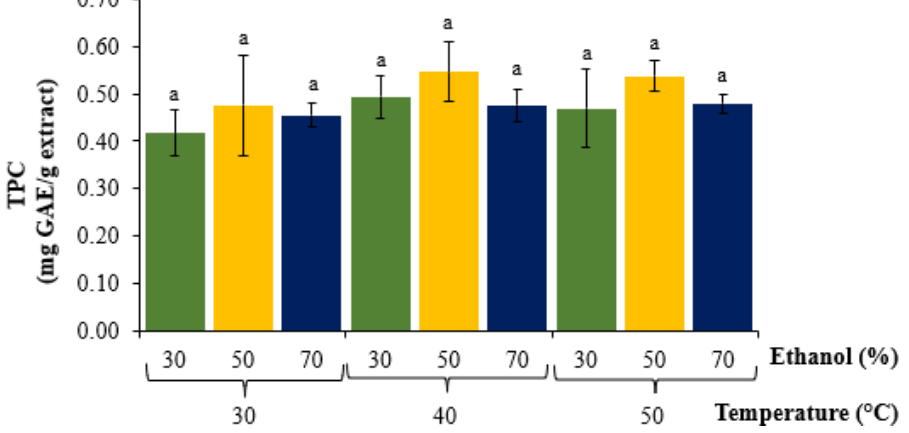
Figure 2. Total phenolic content (mg GAE/g extract) in the RBP extract at different extraction times. Different letters indicate significant differences ( p ≤ 0.05).